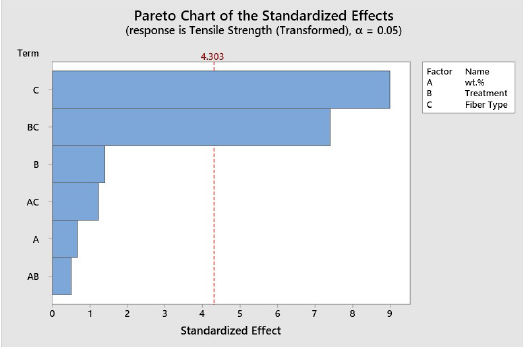
Figure 6. The second-order interaction effect plot of fiber type and treatment for the mean tensile strength.